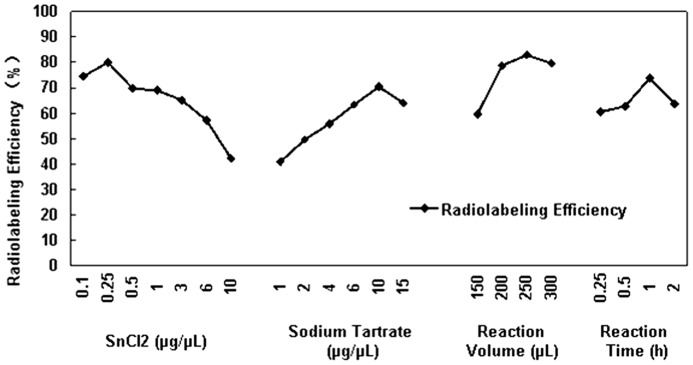
Radiolabeling efficiency.Radiolabeling efficiency of 99mTc-RRL with different conditions. Each time we just changed one condition and fixed others. An orthogonal experimental method was used to find the best radiosynthesis condition.